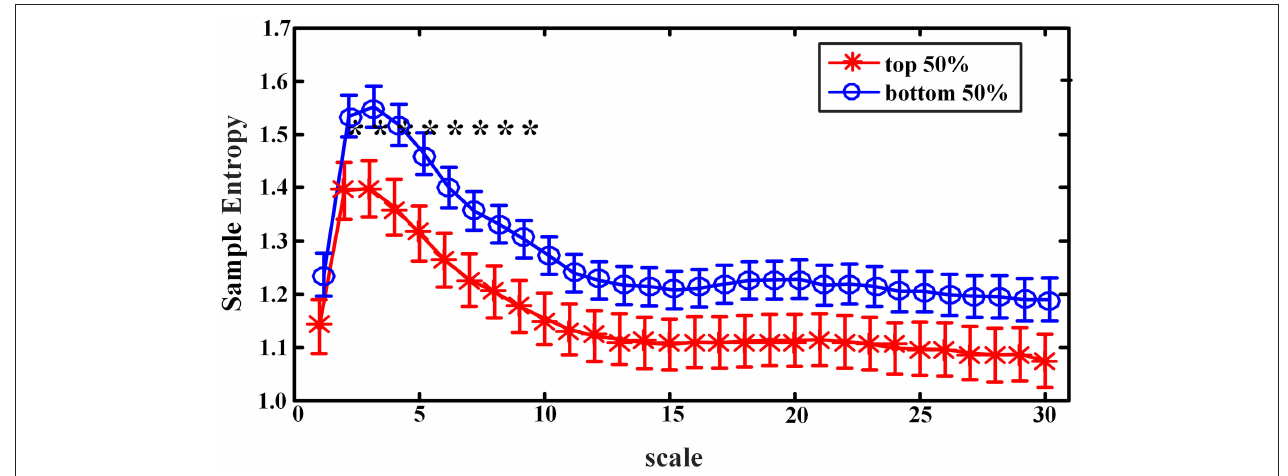
FIGURE 4 | Complexity indices (sample entropy, mean ± standard deviation) on scale 1–30 in groups classified by the rank of FFT-SWA 90 (top 50% vs. bottom 50%). The symbol ‘*’ indicates significant difference between groups ( p < 0.05, covariance analysis, controlling the age, gender and BMI). However, after the procedure of FDR, none of the significant differences